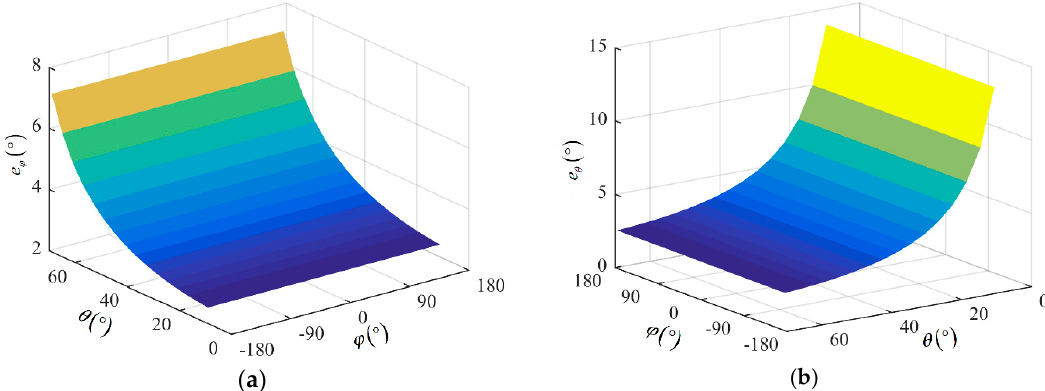
Figure 3. Distributions of e φ and e θ for square array with size of 1 m × 1 m: ( a ) distribution of e φ ; ( b ) distribution of e θ .